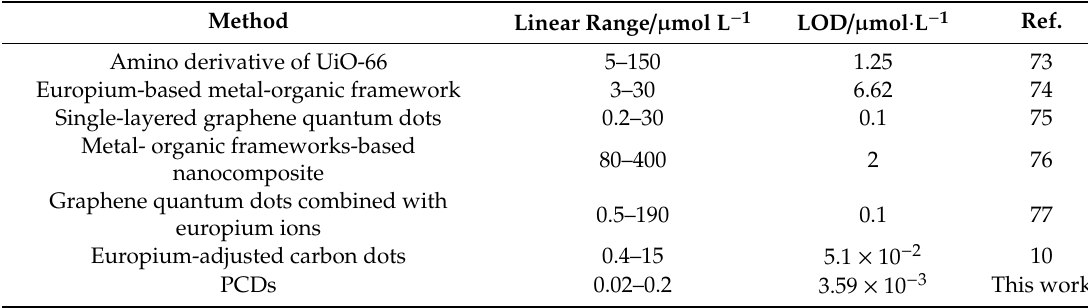
Table 1. A comparison of di ff erent systems for phosphate determination.